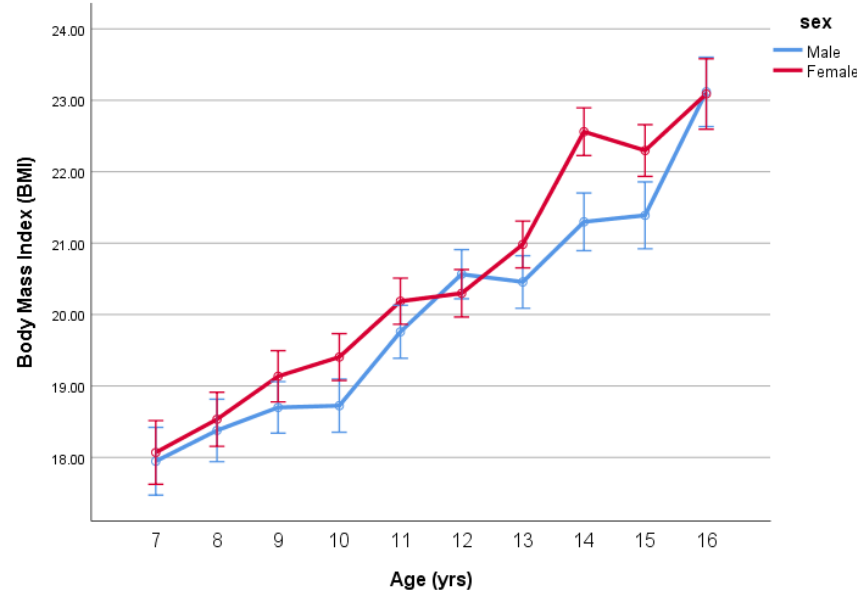
Figure 1. Mean BMI (mean ± SE) by age and sex.